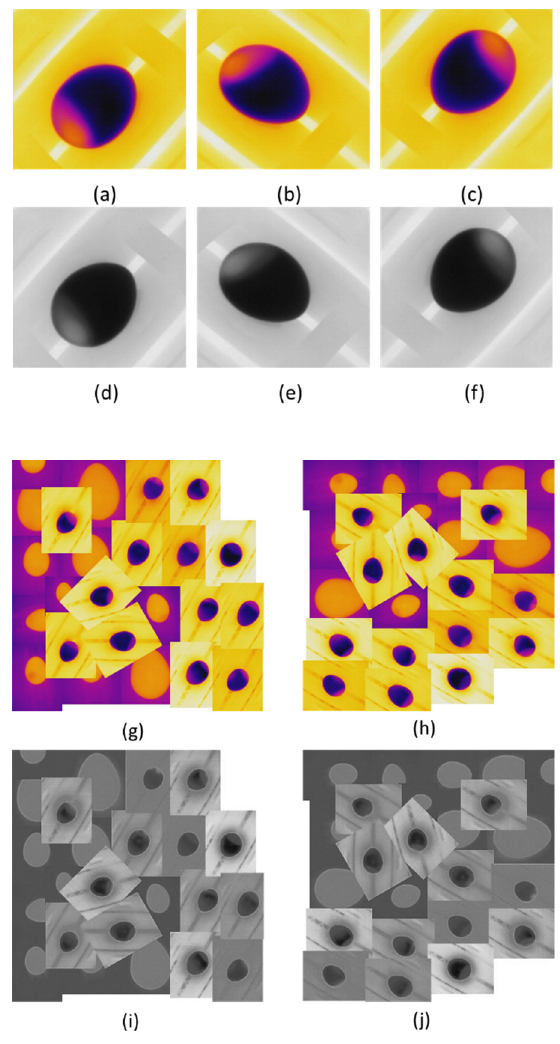
Figure 6. ( a ) Original image. ( b , c ) Free rotations applied to the original image. ( d – f ) Monochrome transformation for pixel augmentation. ( g ) Cutmix original. ( h ) Cutmix + free rotation. ( i , j ) Cutmix + monochrome transformation + free rotation.